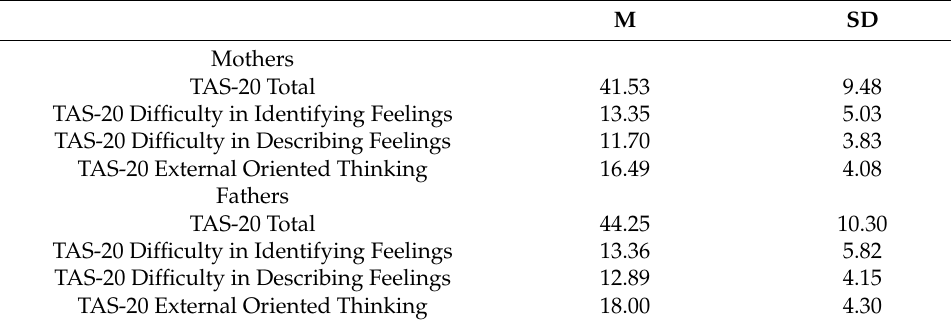
Table 2. Parental alexithymic characteristics.